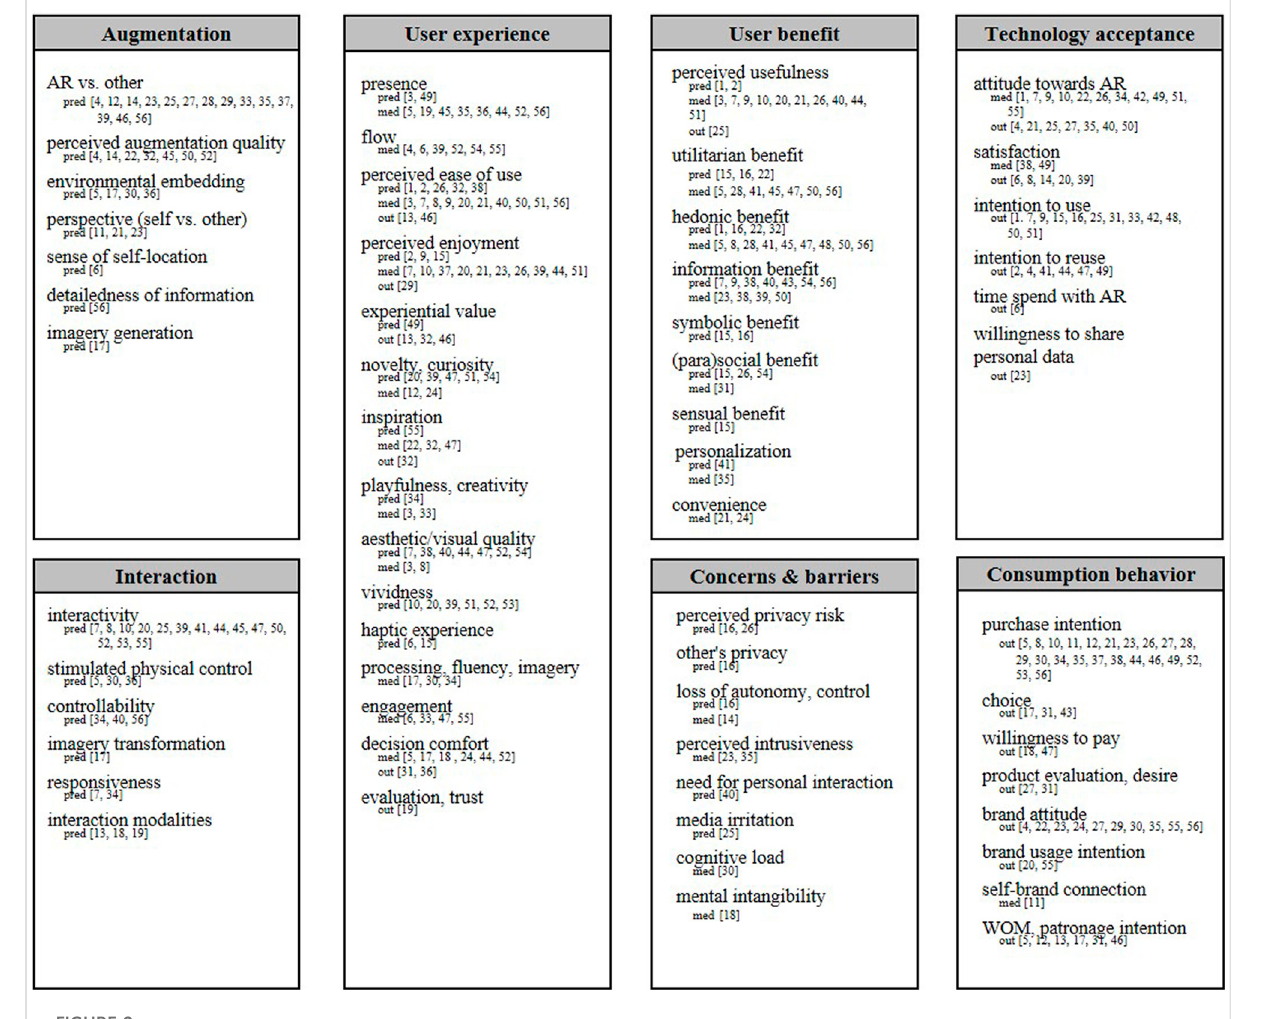
FIGURE 2 Conceptually-structured overview of the researched variables. Notes. Superscripted numbers indicate the study number (see Table 2). Pred = variable used as a predictor variable in the cited study; med = variable used as a mediator in the cited study; out = variable used as an outcome variable in the cited